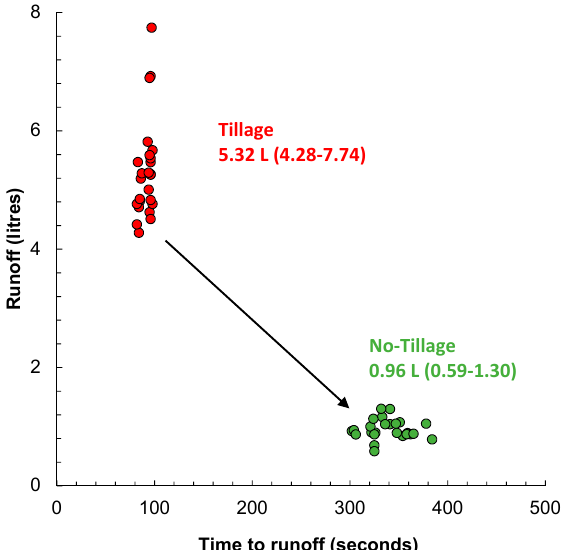
Figure 8. Relation between Time to runoff (s) and Runoff (L) for Tillage and No-Tillage plots (n 25 + 25) at the experimental station “La Cañadeta”.